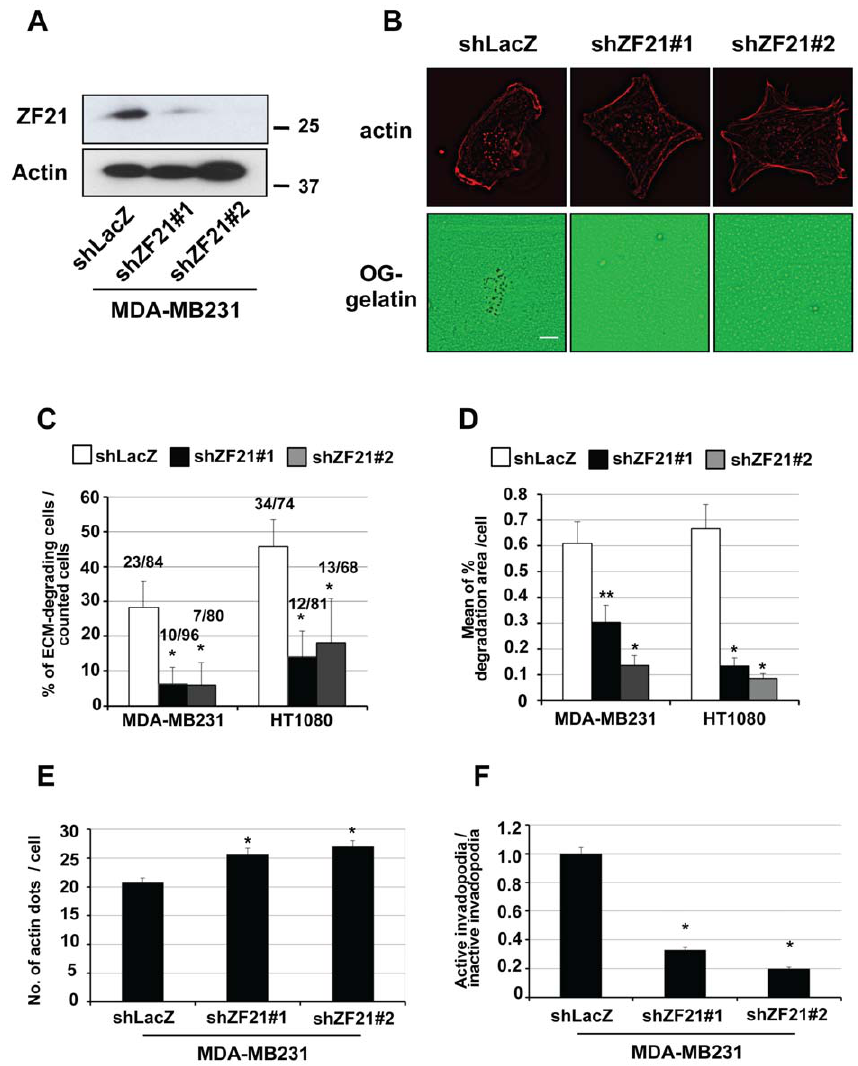
Figure 4. ZF21 knockdown reduces invadopodia-mediated ECM degradation. A. Expression of ZF21 in MDA-MB231 cells was knocked down using either of two shRNA sequences targeting ZF21 mRNA (shZF21 # 1 and # 2). Endogenous ZF21 was detected by Western blot analysis by using a polyclonal anti-ZF21 antibody. B. The cells expressing shLacZ (top) or shZF21 # 1 and # 2 (middle and bottom) cultured on Oregon Green- labeled gelatin-coated glass coverslips. After fixation, the cells were stained with phalloidin for localization of F-actin (red on left panels). Degraded ECM appears as dark areas (reduced green fluorescence on right panels). (scale bar, 10 m m). C. Percentage of cells exhibiting ECM degradation. Number of cells stained with phalloidin was counted and merged with the ECM degraded area. The averaged number of the ECM-degrading cells and total counted cells are indicated upon each column in graphs (ECM-degrading cells/total counted cells). Ratio of the ECM-degrading cells is represent as the means 6 S.D (n=3), *, P , 0.0001, **, P , 0.005. D. Average degradation area per cell is calculated and presented. Error bars indicate the means 6 S.E.M. *, P , 0.0001, **, P , 0.005. E. Number of punctate actin signals was counted for 450–500 cells. Average number of actin dots per cell is presented. Error bars indicate the means 6 S.E.M *, P , 0.0005. The experiment was repeated six times. F. Ratio of ECM-degrading actin dots (active invadopodia) to no ECM-degrading actin dots (inactive invadopodia) is presented. Error bars indicate the means 6 S.E.M *, P , 0.0005.